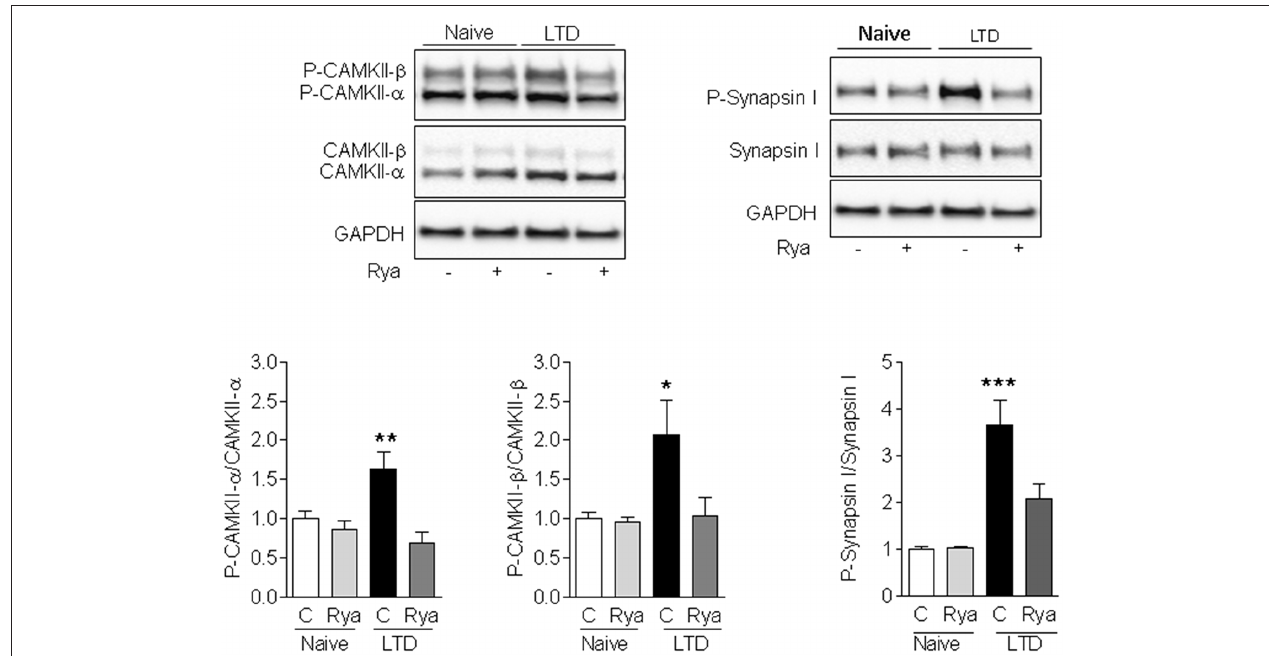
FIGURE 5 | LTD-induced phosphorylation of CaMKII and Synapsin I. Induction of LTD for 60 min in control (C) slices caused a significant increase in the phosphorylation levels of Synapsin I (left panels), CaMKII- α (center panels) and CaMKII- β (right panels) relative to the levels displayed by unstimulated slices (naïve). Slices pre-incubated for 1 h with 20 µ M ryanodine (Rya) before applying the LTD induction protocol displayed significantly lower increments in the phosphorylation levels of Synapsin I and CaMKII- α , whereas the phosphorylation levels of CaMKII- β were not significantly different from the levels displayed by unstimulated slices. Values represent Mean ± SE ( n = 3). Statistical analysis was performed with one-way ANOVA, followed by Tukey’s post hoc test. ∗ p < 0.05 vs. naíve; ∗∗ p < 0.01 vs. naíve; ∗∗∗ p < 0.001 vs.